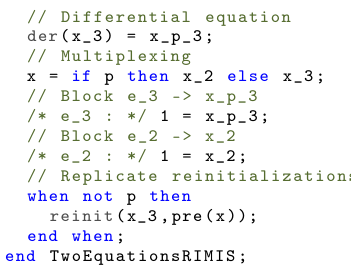
Figure 27. Two Equations model in RIMIS form.